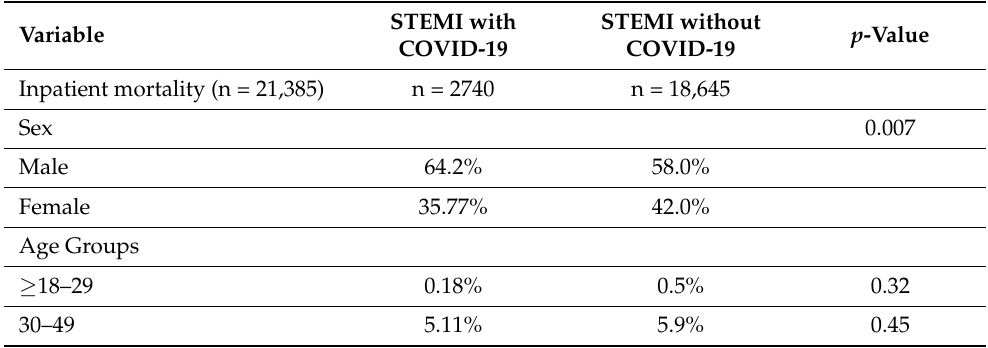
Table 3. STEMI In-Hospital Mortality Sub-Group Analysis Based on COVID-19